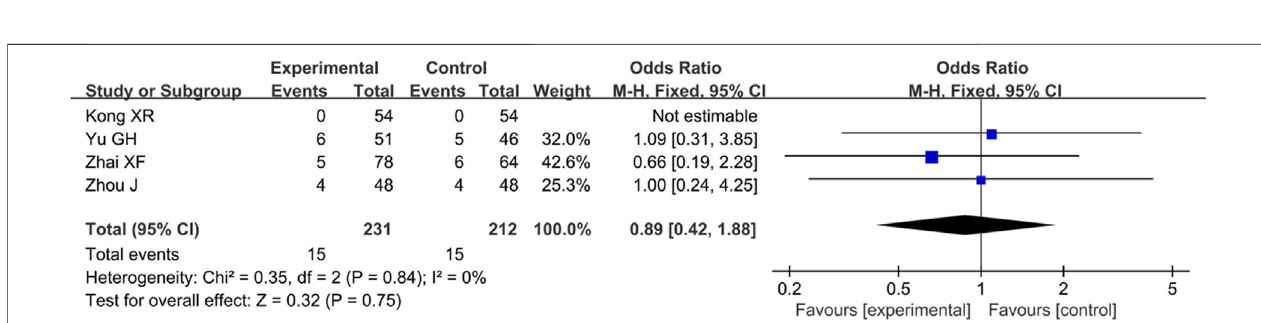
Frontiers in Pharmacology |